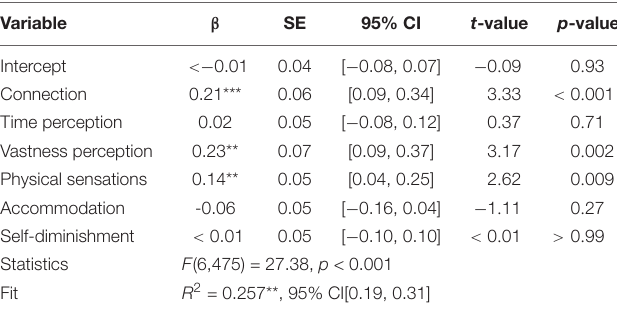
TABLE 4 | Model for Hypothesis 1d: Predicting transformativeness with the awe